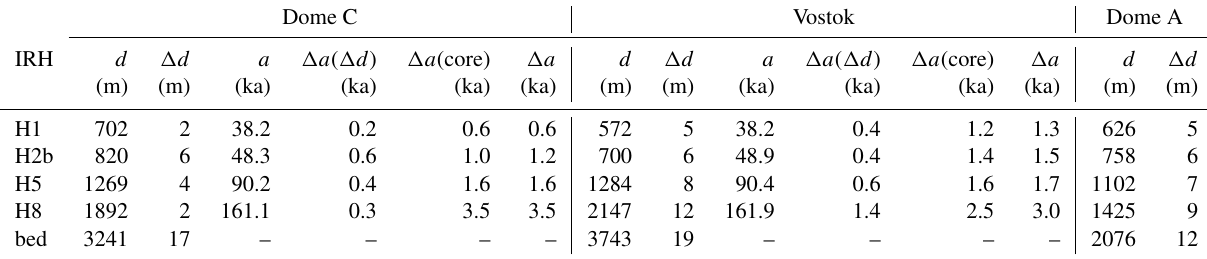
Table 2. The depths d below ice surface of the four IRHs and the bed in the CEA region (at Dome C, Vostok and Dome A) with depth uncertainties (cid:49)d and their ages a from the EDC and Vostok AICC2012 ice-core age scales (Bazin et al., 2013; Veres et al., 2013). The age uncertainties are separated in contributions from depth uncertainties (cid:49)a ( (cid:49)d ) and age-scale uncertainties (cid:49)a (core). (cid:49)a is the total age